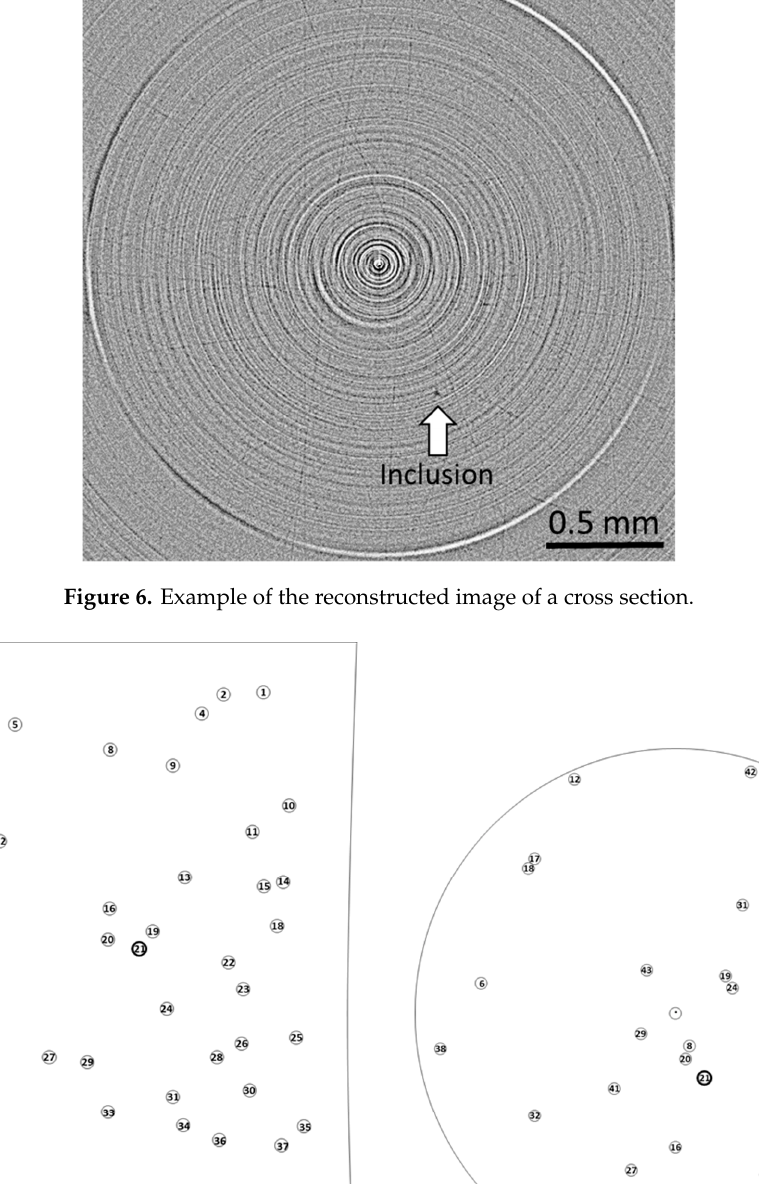
Figure 5. Example of a radiograph.